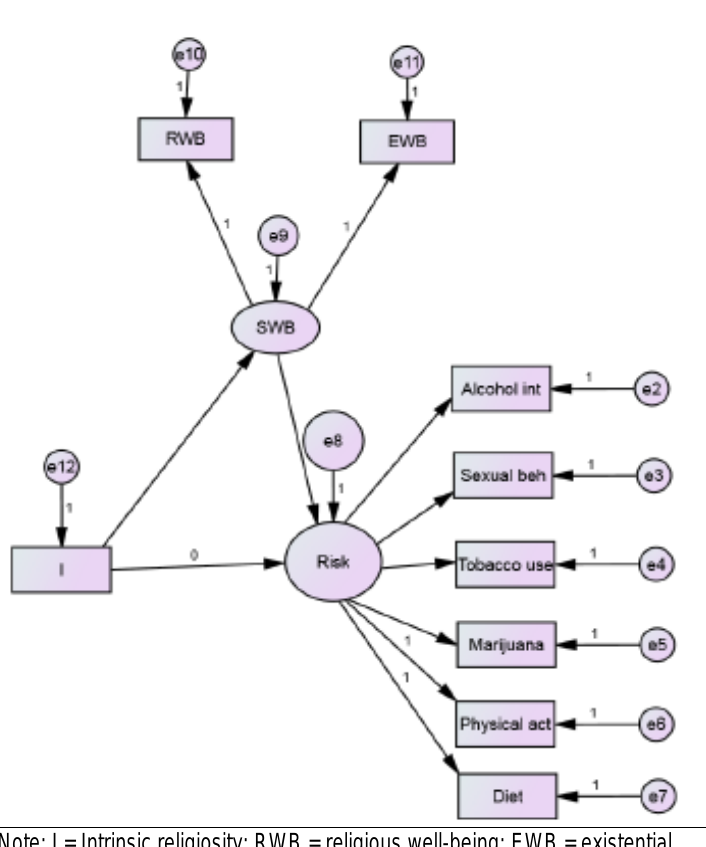
Figure 1a: Associations between spirituality/religiosity and health risk behaviours: Spirituality-mediated